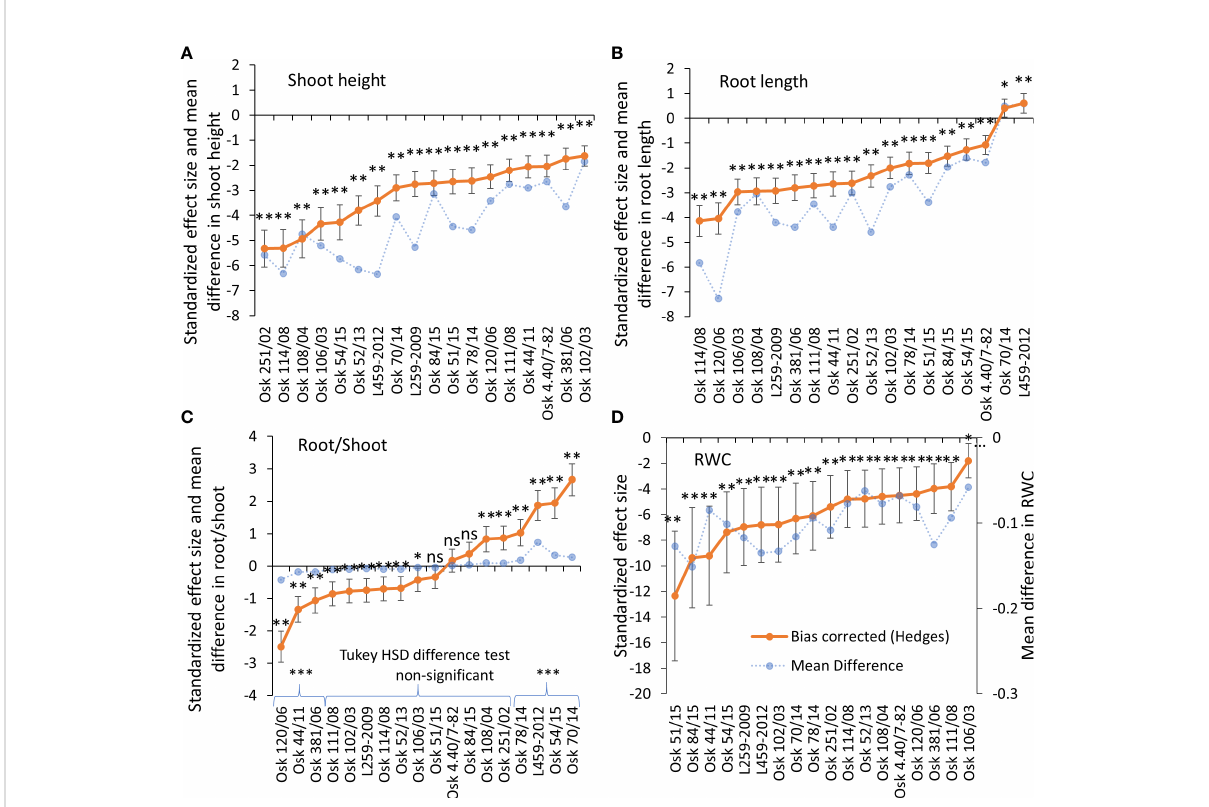
FIGURE 1 Hedges bias-corrected treatment effect size (with con fi dence interval) and the mean difference in shoot height (A) , root length (B) , root-to- shoot ratio (C) , and relative water content (RWC) (D) between PEG-induced drought and control treatment in 18 genotypes of wheat seedlings. Signi fi cant effects of PEG-induced drought are marked with asterisks (* p<0.05, ** p<0.01, *** p<0.001), and ns stands for non-signi fi cant (p > 0.05). Based on the Tukey HSD difference test, signi fi cant differences were determined in root-to-shoot ratio for Osk 120/06, 44/11, and 381/06 (decreased root/shoot induced by drought) and for Osk 78/14, 54/15, 70/14, and L459-2012 (increased root/shoot ratio induced by